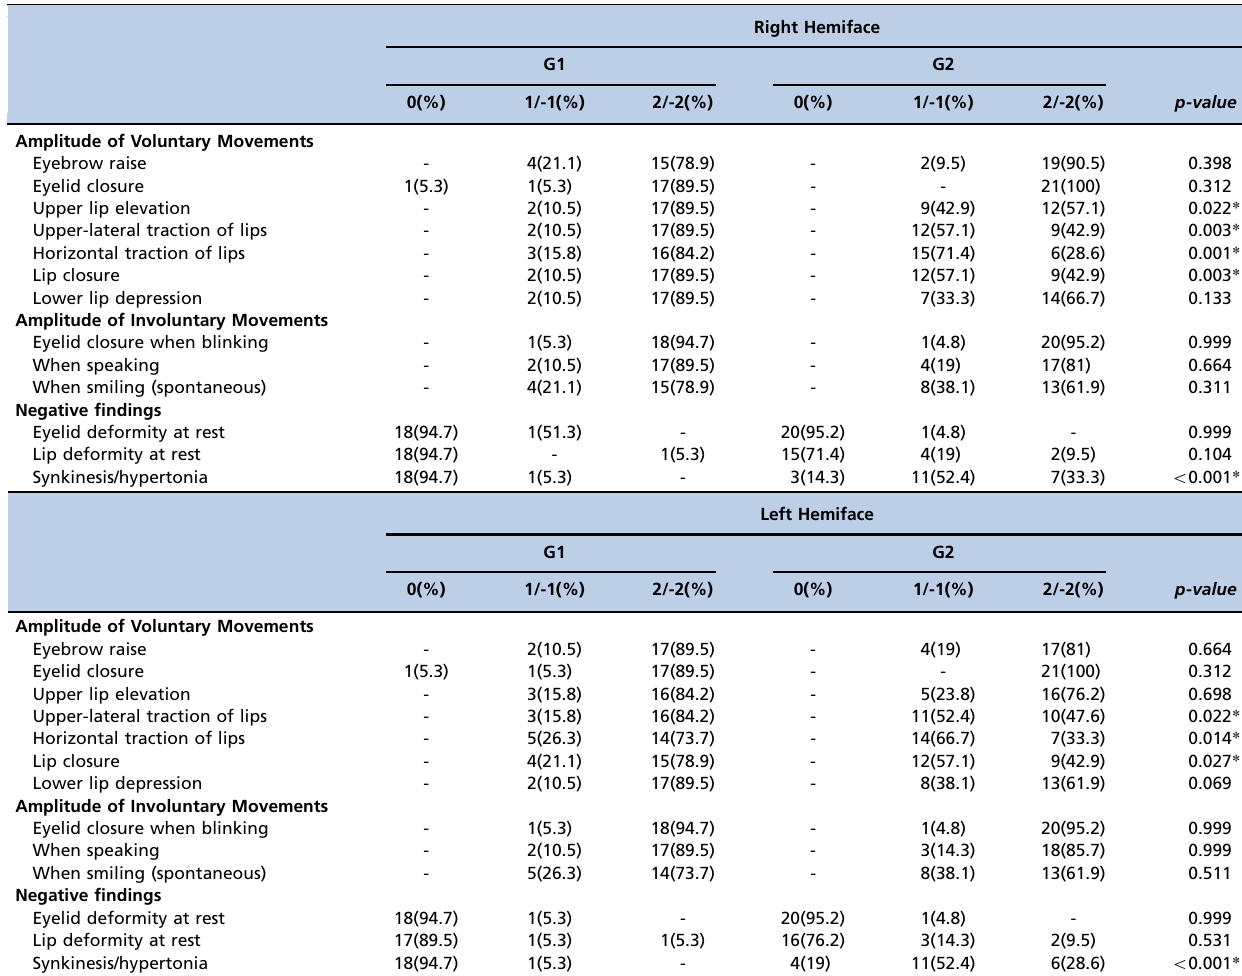
Table 6 - Results of the Clinical Score for Facial Mimic Protocol in deep partial-thickness burns – G1 (n=19) and full- thickness burns – G2